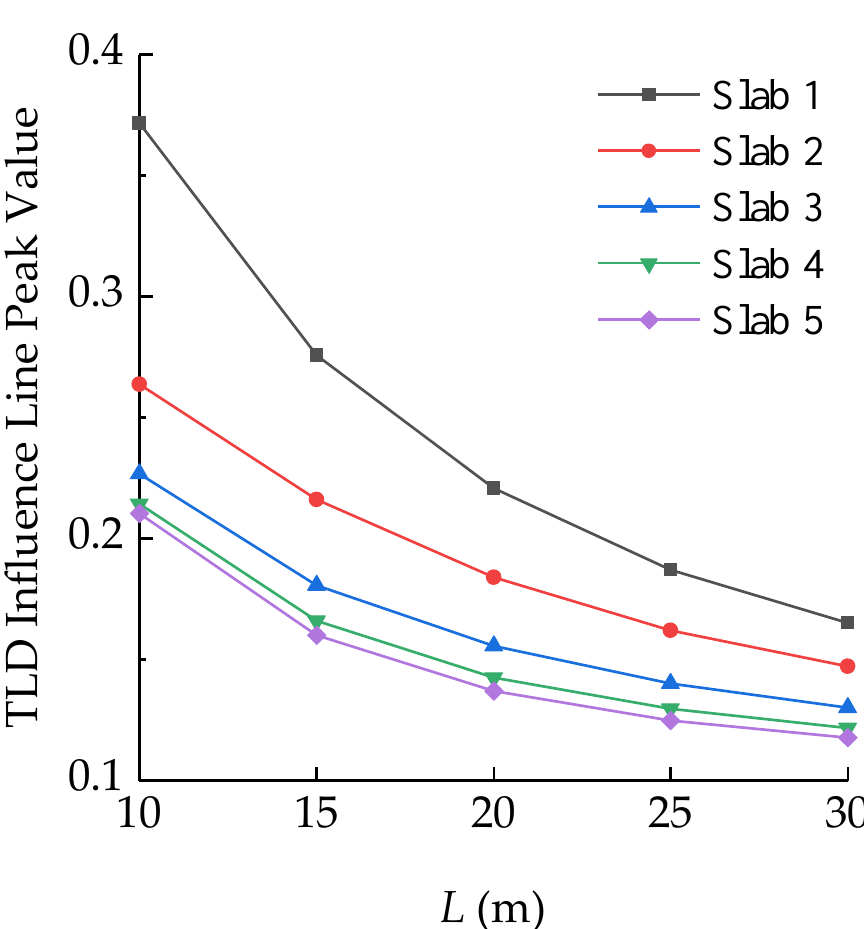
Figure 14. The peak values of the TLD influence line of each slab at different spans.